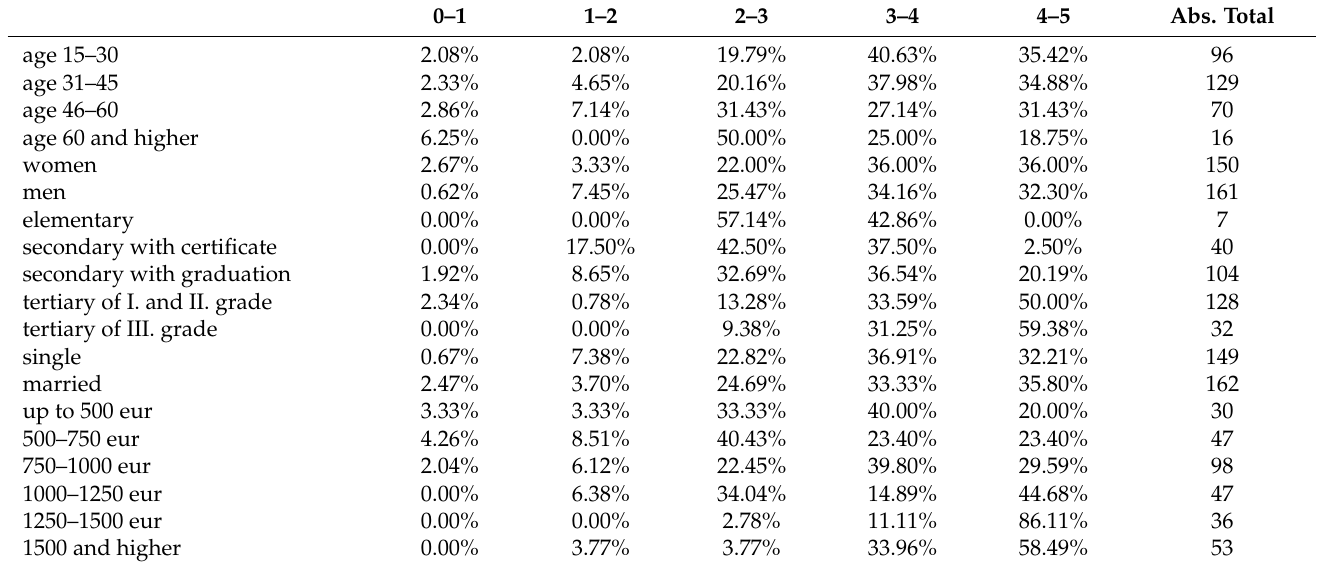
Table 2. Share of population within intervals of relational health score by age, gender, education, marital status and level of income.